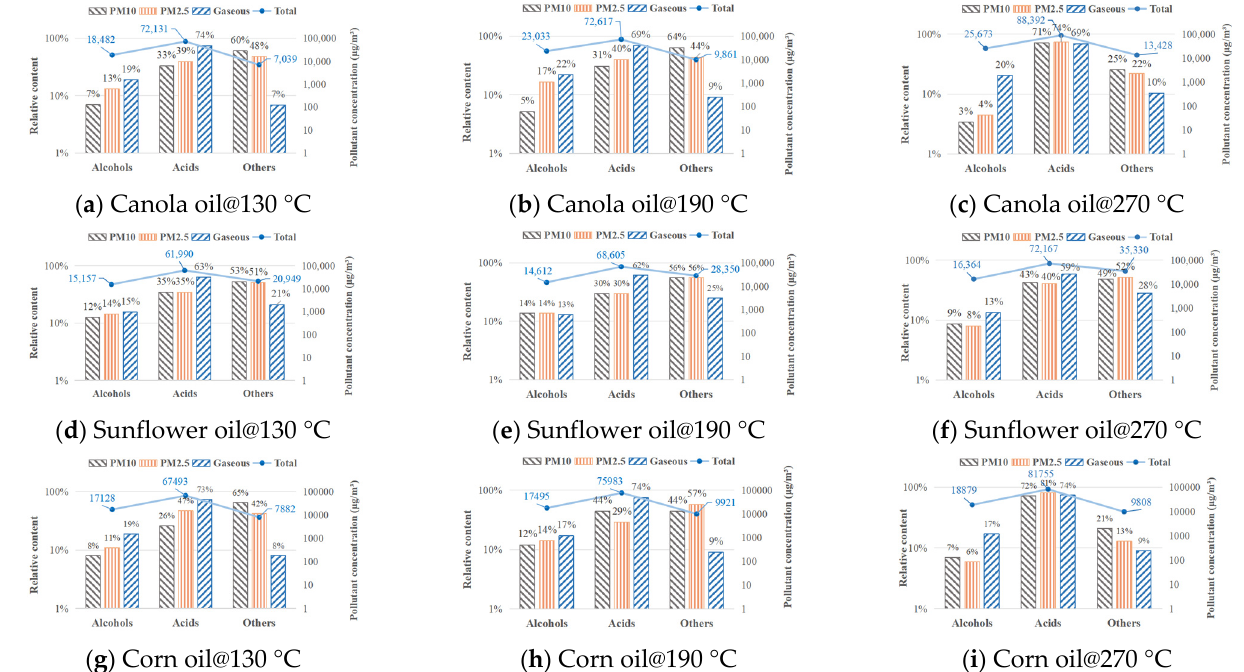
Figure 5. Emission rate and composition of VOCs.